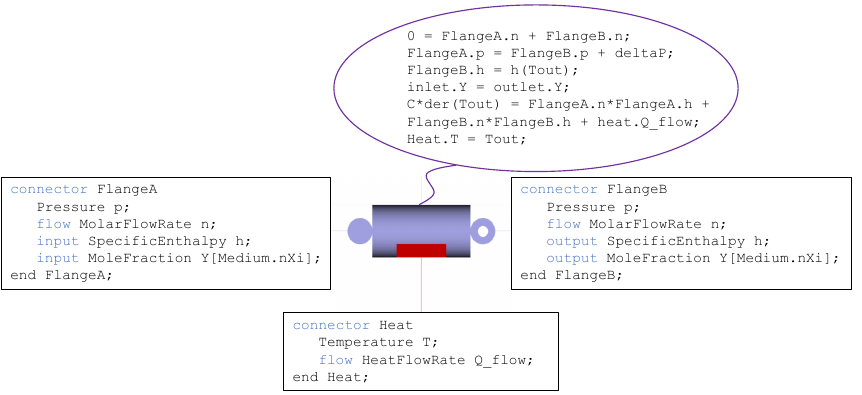
Figure 6. Representation of the fluid element (base model) in Modelica with two fluid ports and a heat port, with indication of the equations within the element.